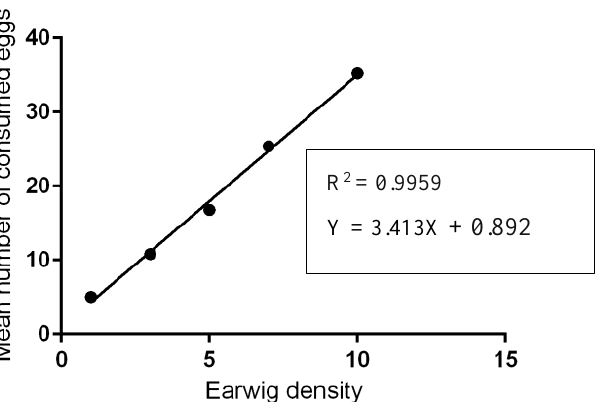
Figure 4. The number of eggs consumed by adult earwigs present in each ratio after 24 h. The plain line is the estimated linear regression (R 2 = 0.99, p = 0.0001).